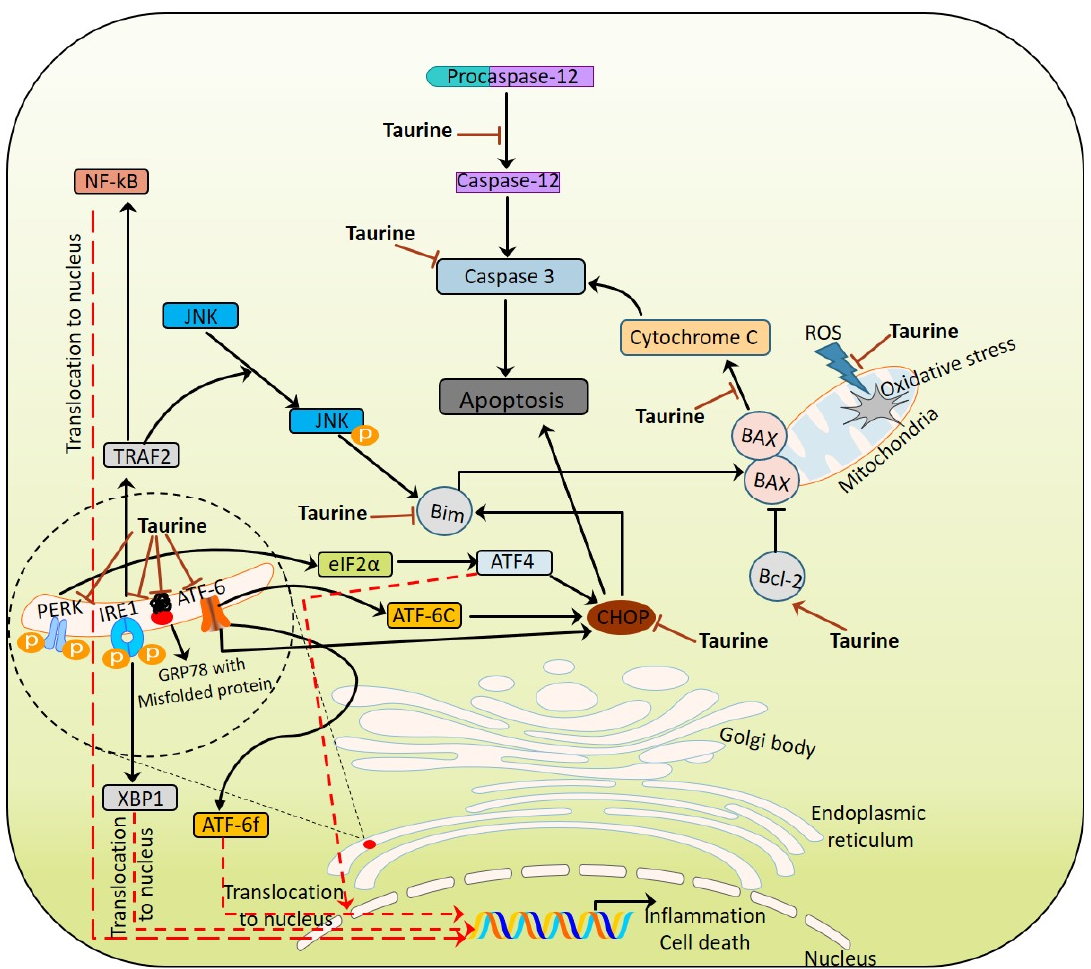
Figure 2. Taurine combatting Mitochondria—Endoplasmic Reticulum stress module.